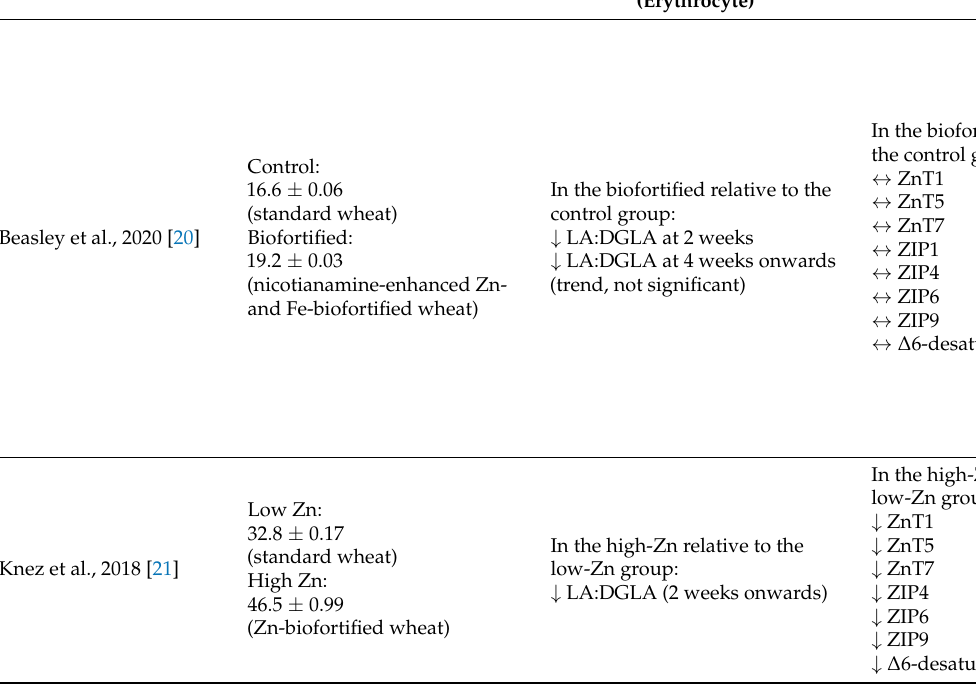
Table 3. Results of studies assessed for the ZSI: LA:DGLA, Zn-related gene expression, and Zn status effects on gut microbiota modulation.